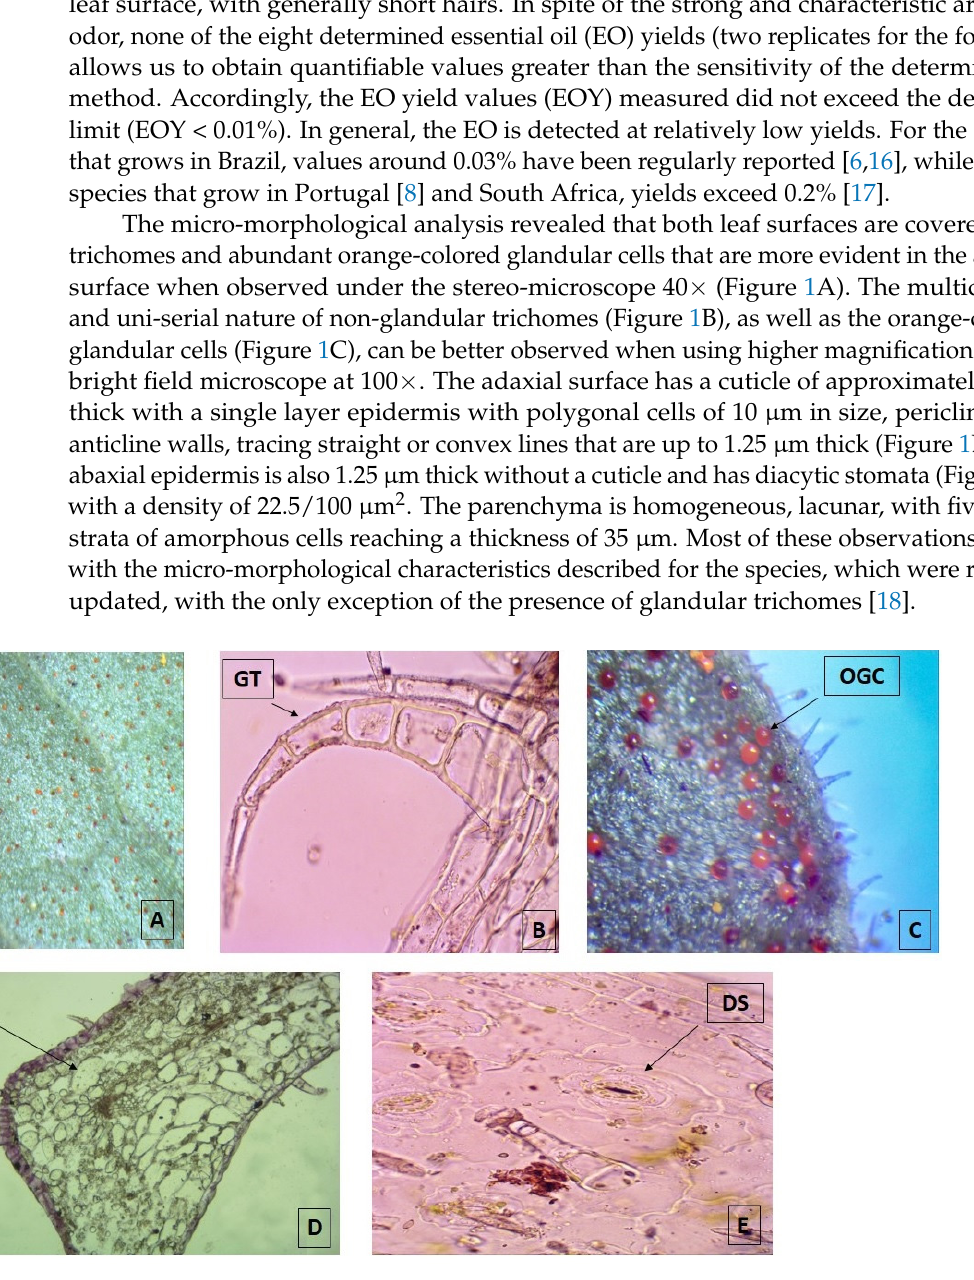
Figure 1. Photomicrograph of transverse sections of leaves from Plectranthus neochilus collected in Santiago de Cuba. ( A ) Adaxial surface of the foliar lamina. ( B ) Non-glandular trichomes. ( C ) Orange-colored glandular cells. ( D ) Polygonal cells. ( E ) Diacytic stomata. ( A ) × 40× and ( B – E ) × 100×.